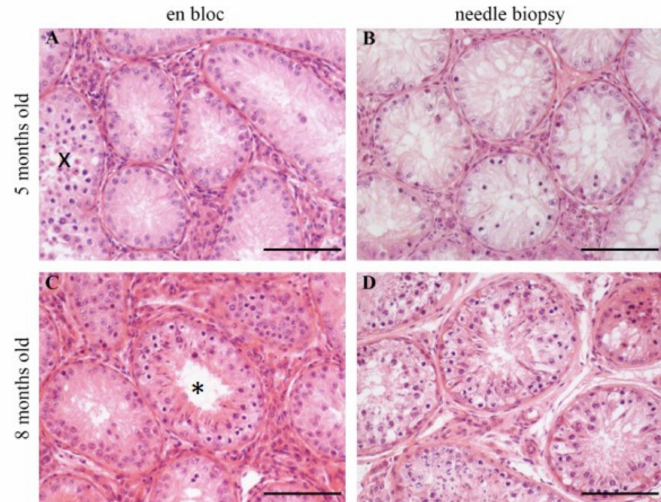
Figure 3. Representative haematoxylin-eosin (HE) microphotographs of testicular tissue sections of calves of the younger (five months old) and older (eight months old) age group. Scale bars = 100 µ m. A and C represent en bloc samples and B and D represent needle biopsy samples. En bloc samples obtained conventionally (A, C), testicular morphology, e.g., tubular lumen (3C asterisk) are better preserved than needle biopsy samples (B, D). In younger bull calves (A, B), advanced spermatogenic cells (e.g., spermatocytes) appear rarely but are still visible compared to older animals (C, D). In younger calves (A), a tubule containing spermatocytes is present